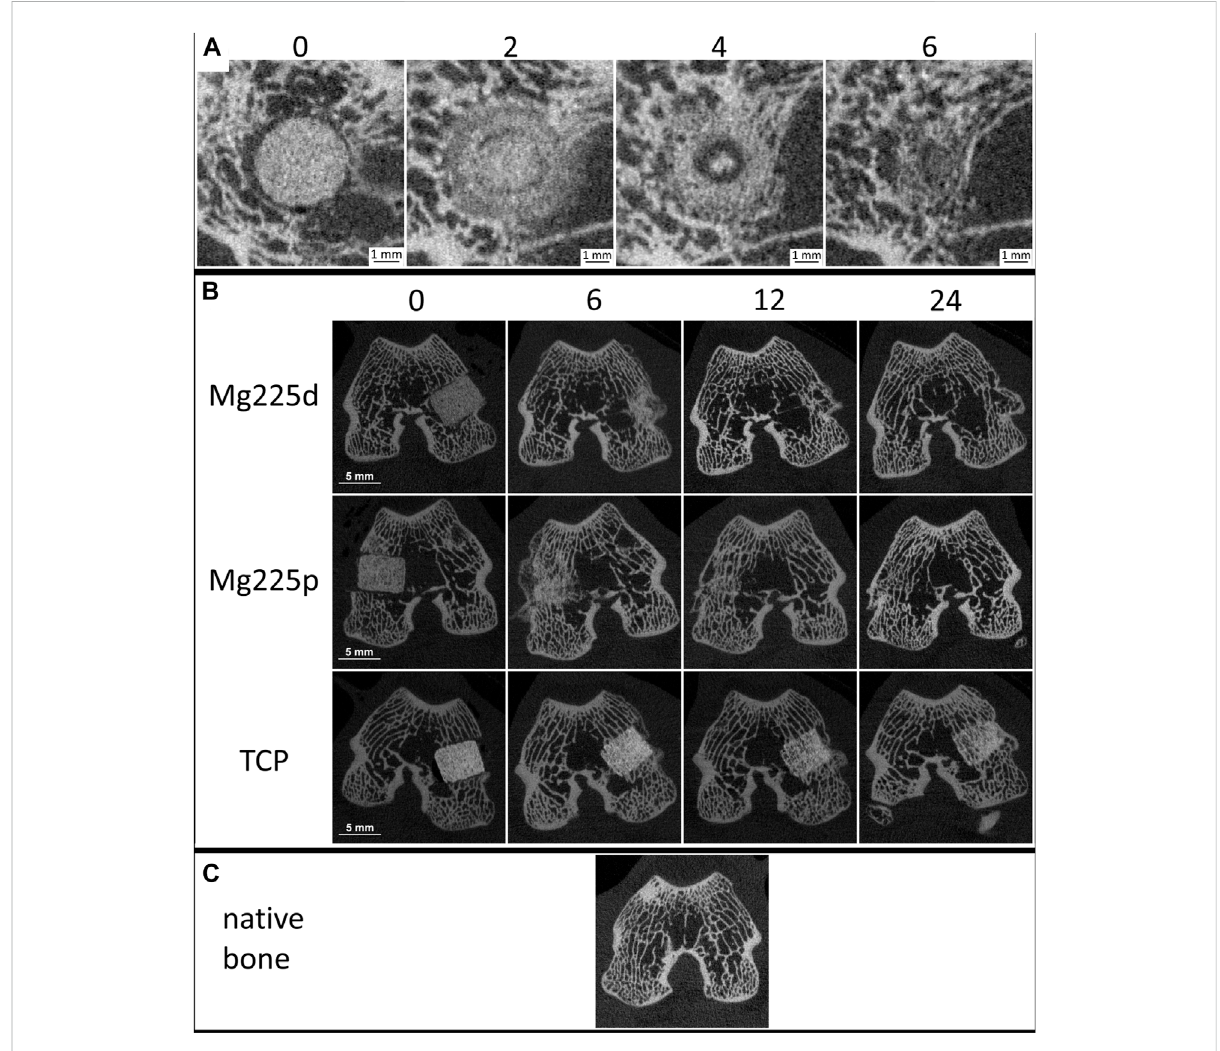
FIGURE 4 (A) In-vivo µCT images of Mg225d and surrounding cancellous bone in cross section over time (directly after surgery up to 6 weeks) with increasing scaffold-bone-contact and resorption zone. (B) In-vivo µCT images of the scaffolds (Mg225d, Mg225p and TCP) implanted in the distal femoral condyles over time (directly after surgery up to 24 weeks) (C) compared to native cancellous bone of the distal femoral